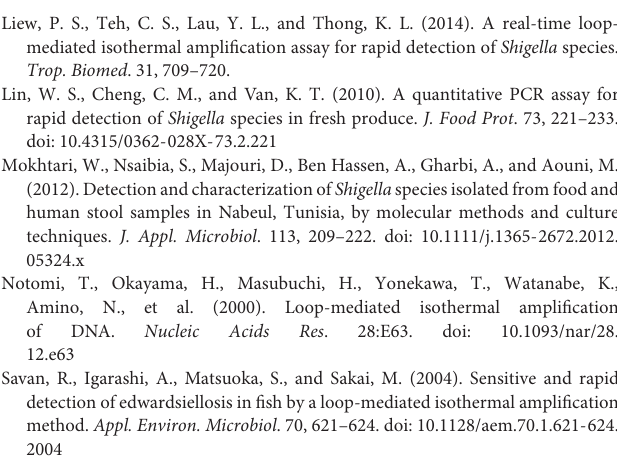
FIGURE S3 | Schematic diagram of IC-LAMP. TABLE S1 | Bacterial strains used in this